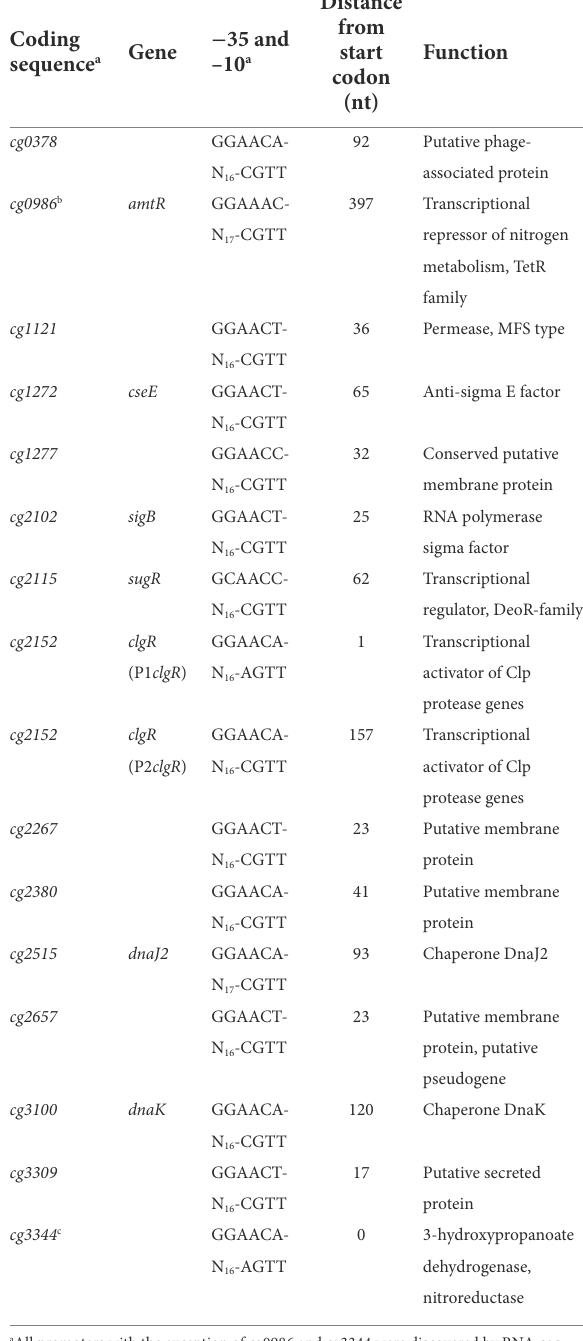
TABLE 2 Genes and corresponding promoter sequence motifs − 35 and − 10 which were found to be both σ H - and σ Ε -controlled.